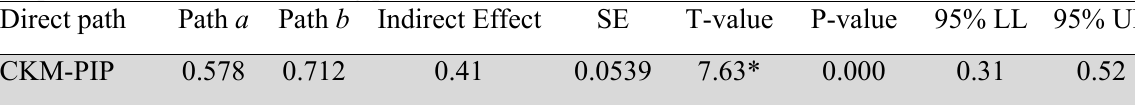
The path coefficient of mediating